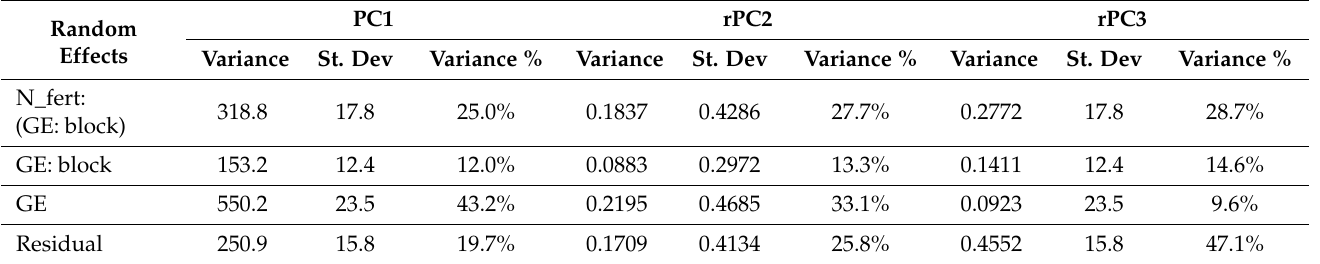
Table 5. Fixed effect results and significance in the estimation of the PCs loading values.